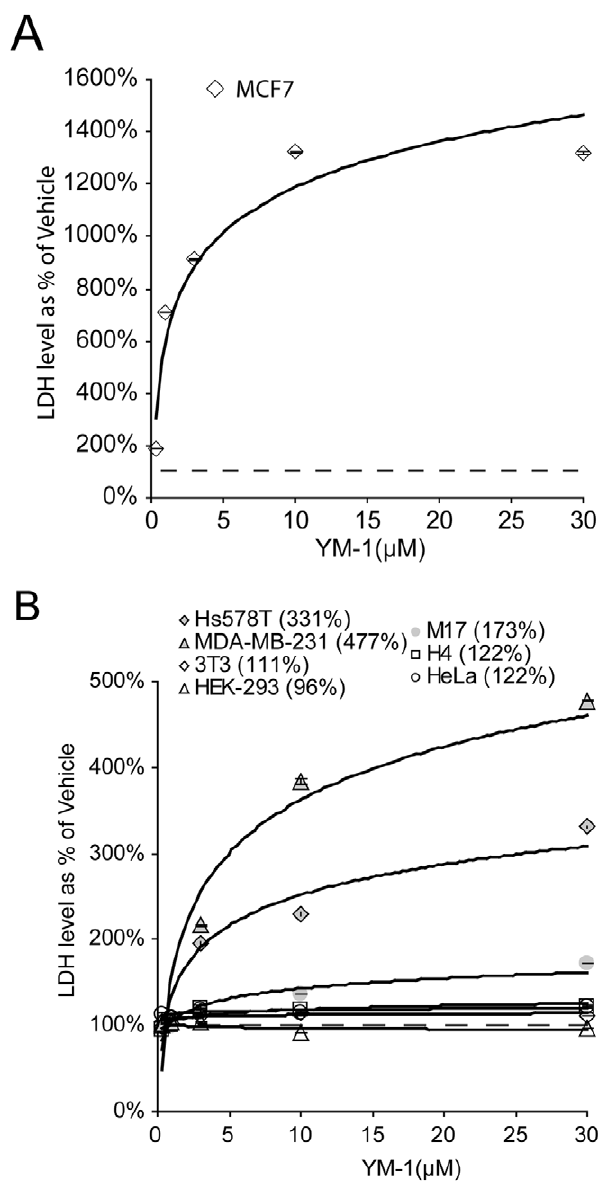
Figure 2. YM-1 toxicity specific to cancer cells; non-cancer cells unaffected. MCF7 cells (breast cancer) were treated for 24 hours with increasing concentrations of YM-1. After 24 hours, medium was collected and analyzed by LDH cytotoxicity assay. Values shown are a % of vehicle treatment 6 SD (A). Hs578T and MDA-MB-231 (breast cancer), M17 (neuroblastoma), H4 (neuroglioma), and HeLa (cervical cancer) cell treated with increasing concentrations of YM-1 and the toxicity was compared to NIH-3T3 (mouse embryonic fibroblast) and HEK 293 (human embryonic kidney) cells for cancer specific toxicity. All cell lines were treated for 24 hours. After 24 hours, media were collected and analyzed by LDH assay. Values shown are a % of vehicle treatment 6 SD (B).